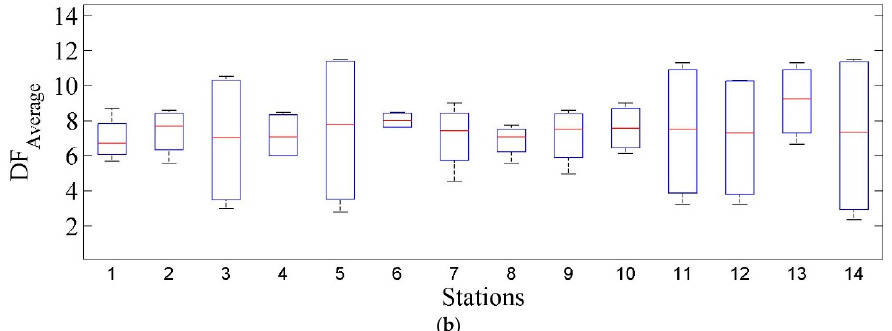
Figure 10. Same as Figure 8 but for DF (in percentage drought events per year).